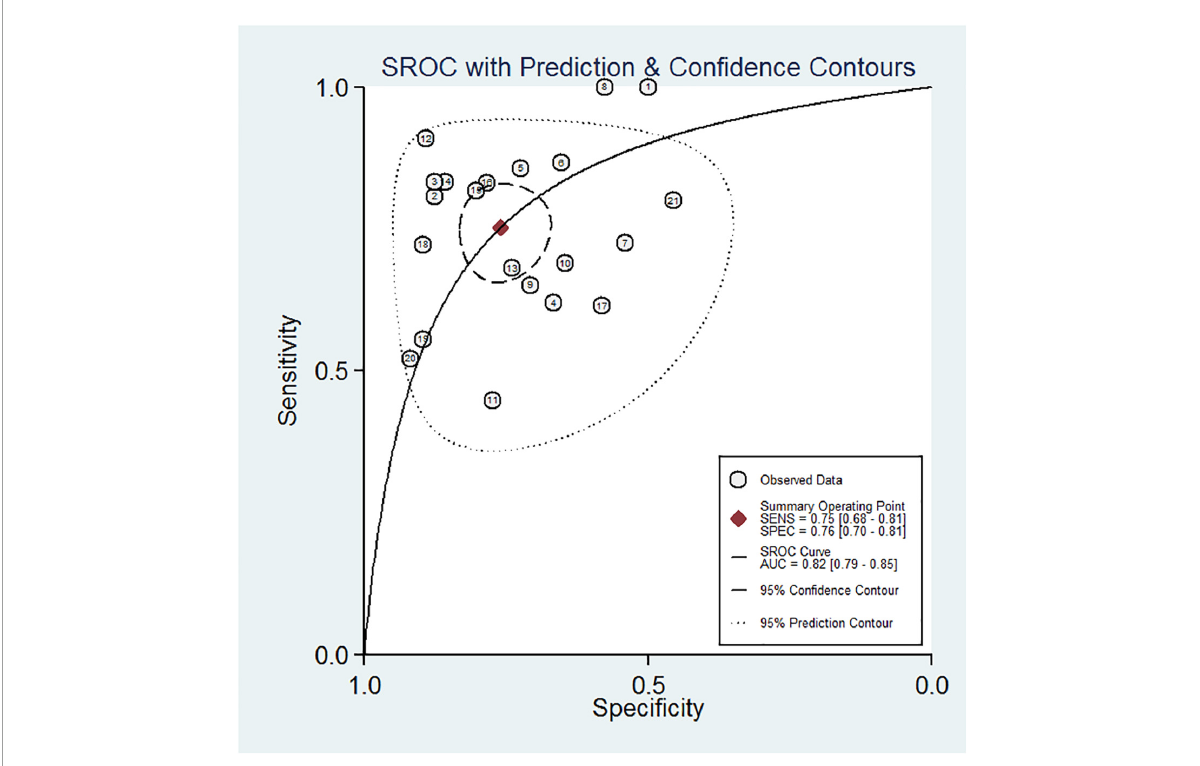
FIGURE5 Summary receiver operating characteristic (SROC) curve of plasma/serum and urine NGAL for AKI requiring RRT.